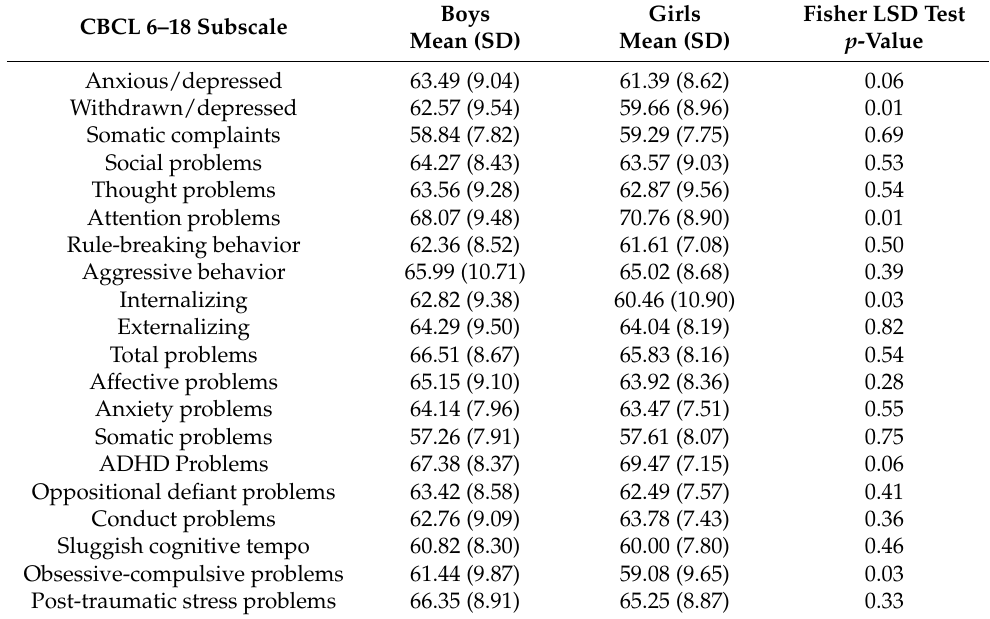
Table 2. Results of comparison between boys and girls with ADHD on CBCL 6–18